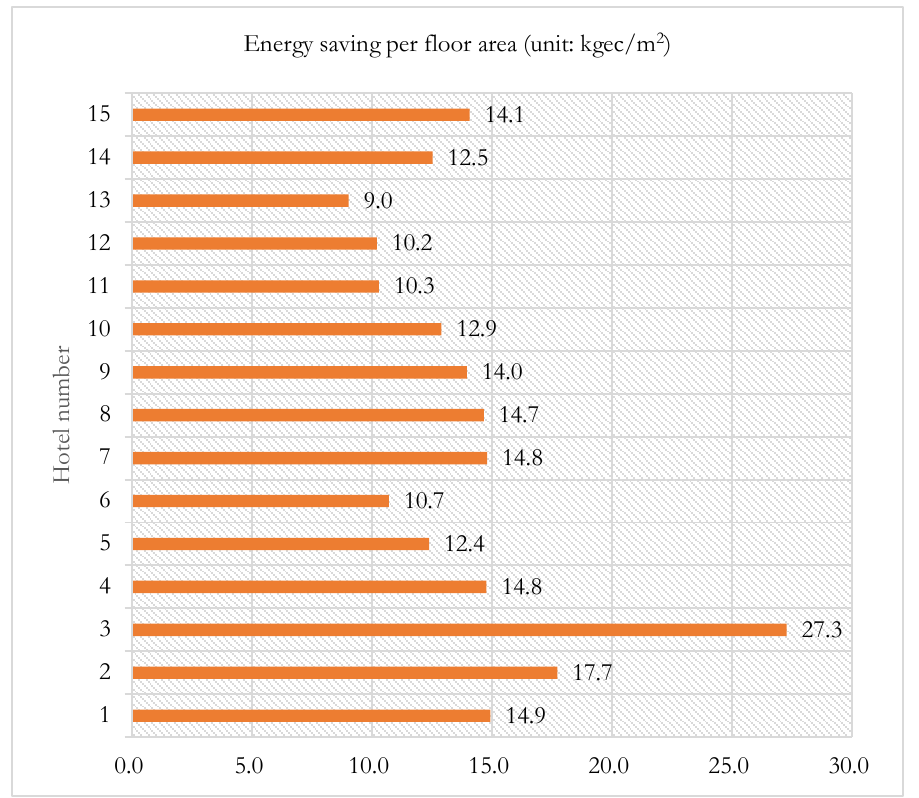
Figure 3. Comparison of energy savings per floor area.